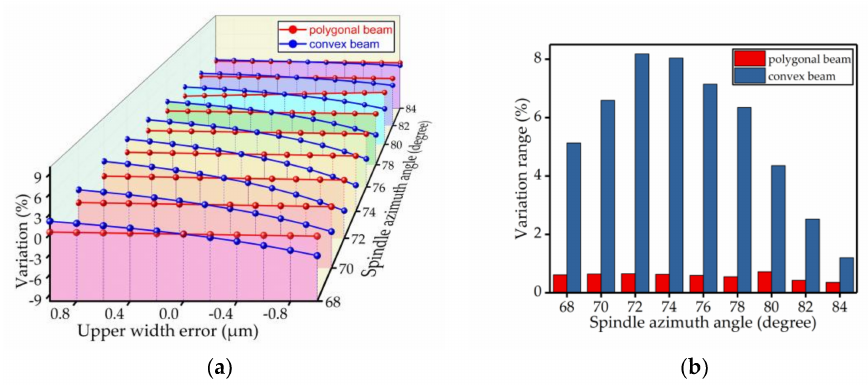
Figure 12. The influence of the upper width error on the spindle azimuth angle of the polygonal cross-section beam and convex cross-section beam; ( a ) shows the relationship between spindle azimuth angle variation and upper width error; ( b ) shows the range of variation—the value is the difference between the maximum and minimum values of each